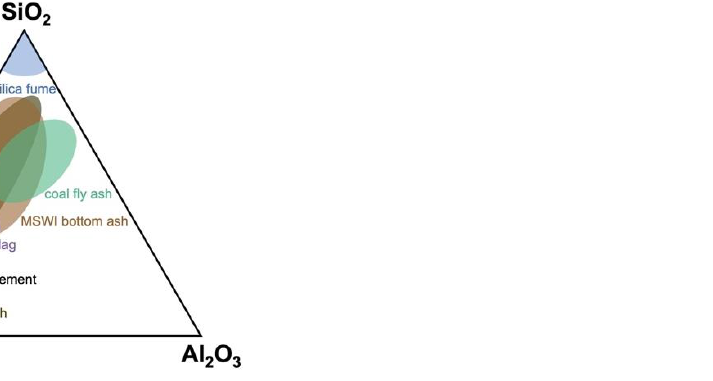
Figure 2. Approximate compositions of Portland cement, MSWI ash, and common industrial byproducts as cement substitutes (coal fly ash, silica fume, and ground granulated blast-furnace slag (GGBFS)). Coal fly ash, silica fume, and GGBFS are byproducts from coal-fired power plants, silicon/ferrosilicon manufacture, and crude iron production, respectively.